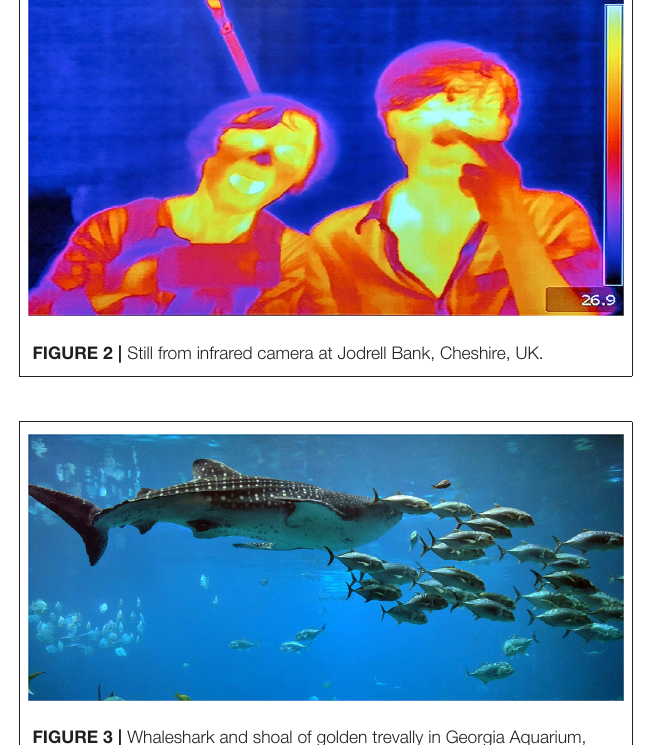
fish generate complex water movement that may confuse their predators